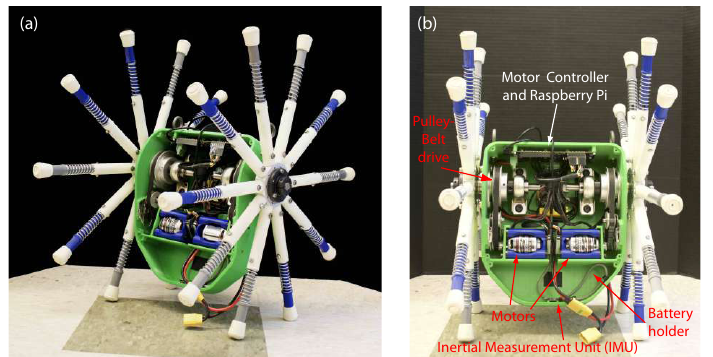
Figure 1. Robot: ( a ) Rimless wheel side view and ( b ) with important components labeled.